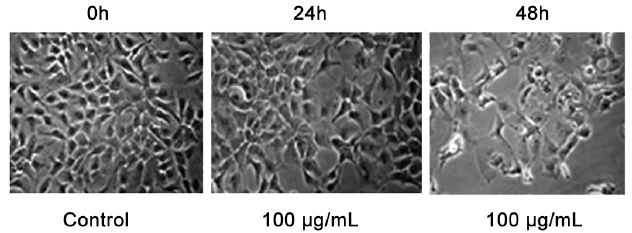
FIGURE 2 - Effects of IC mace extract.